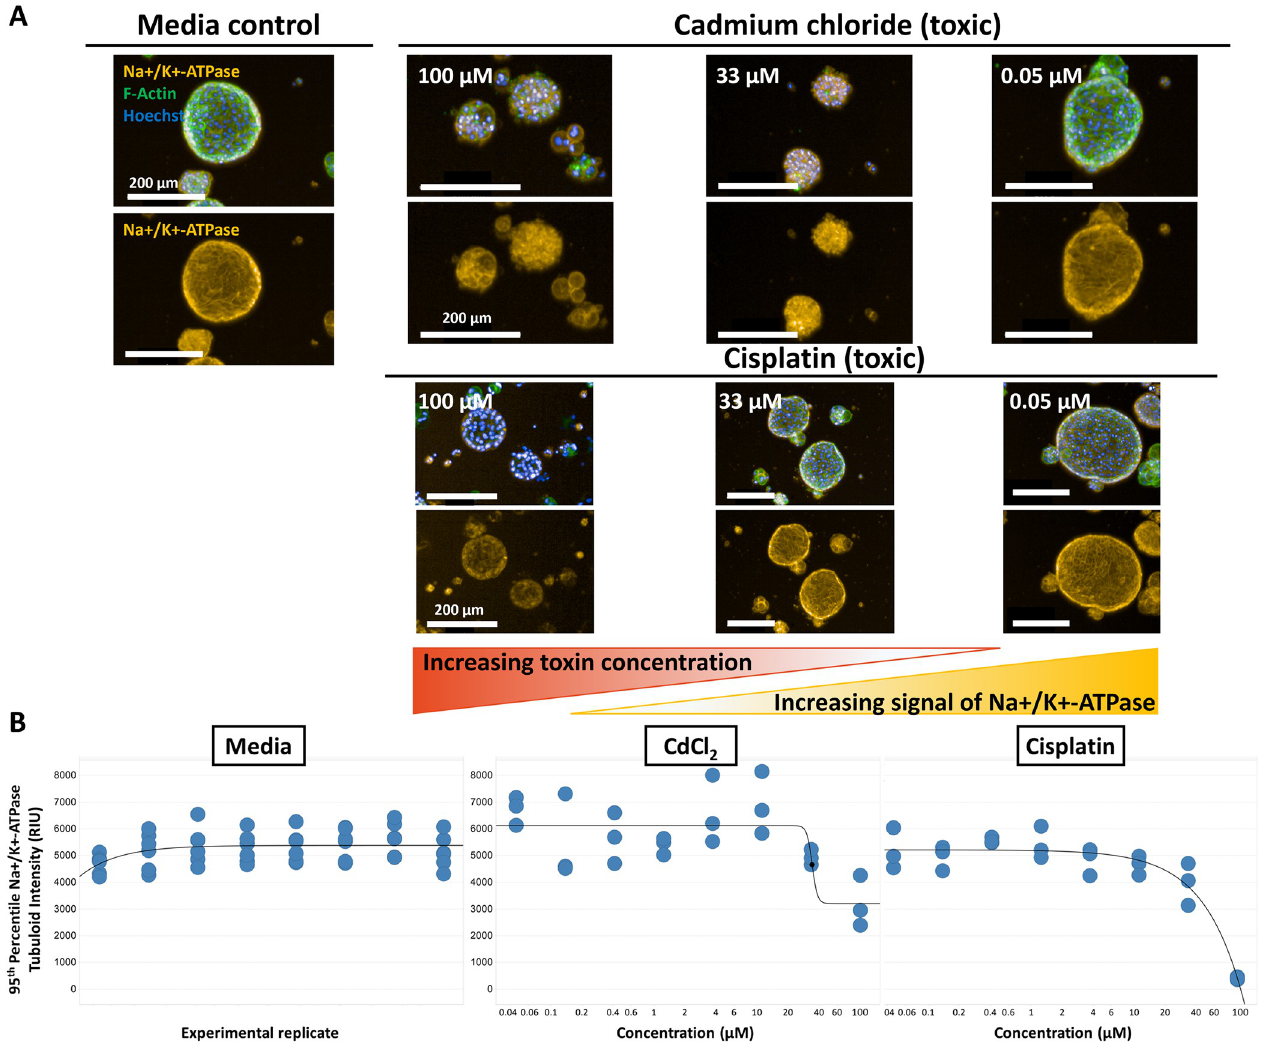
Fig 5. Nephrotoxicity image analysis of 3D tubuloids as a potential phenotypic screening tool. (A) Na+/K+-ATPase signal intensity in relative intensity units (RIU) diminishes with increasing dose of known nephrotoxins at 24-hour post-dose compared to media (non-toxic) control, scale bars are 200 μ m. (B) Image quantification of the 95th percentile Na+/K+-ATPase Tubuloid intensity with respect to concentration at 24 hours